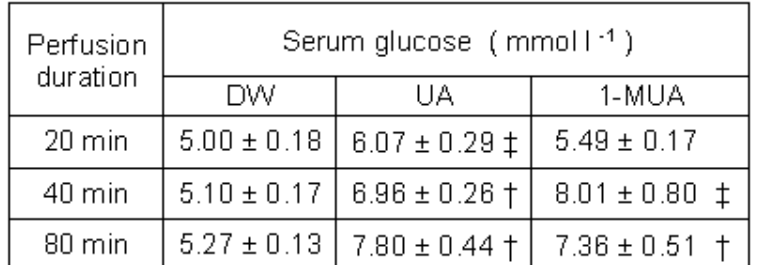
Serum Glucose Levels Following Perfusion of the Urinary Bladder with DW or UA or 1- MUA at 20, 40, and 80 min